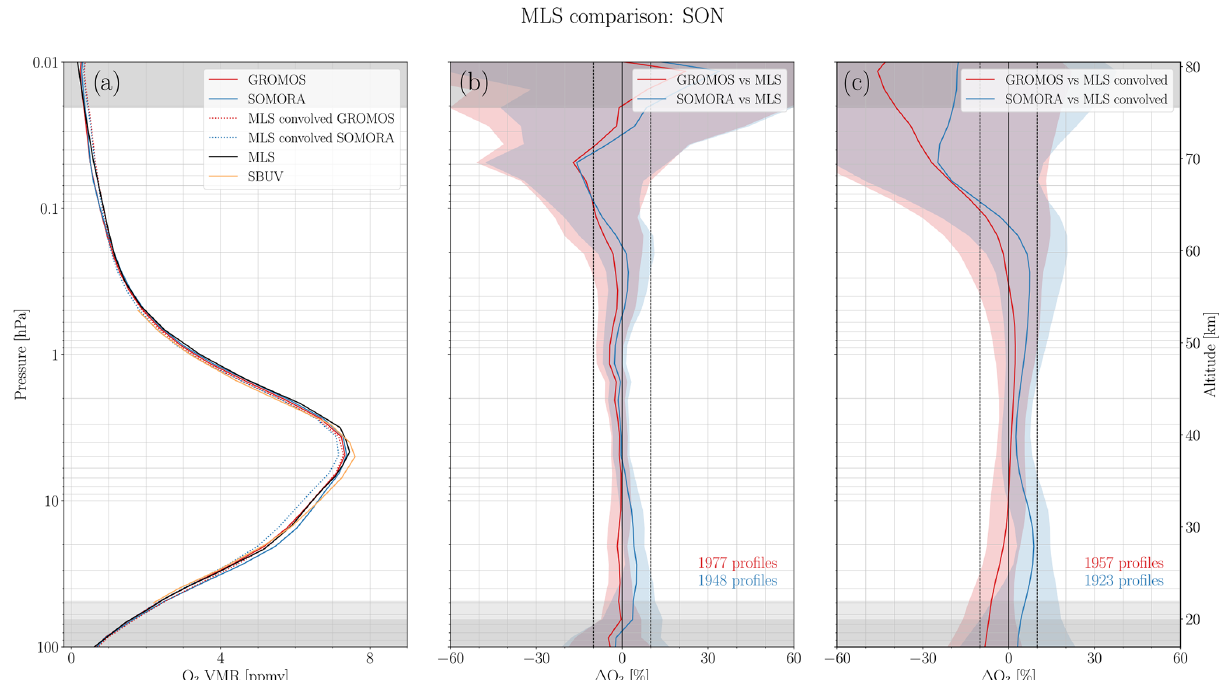
Figure C2. The same as Fig. 11 but for autumn (September, October and